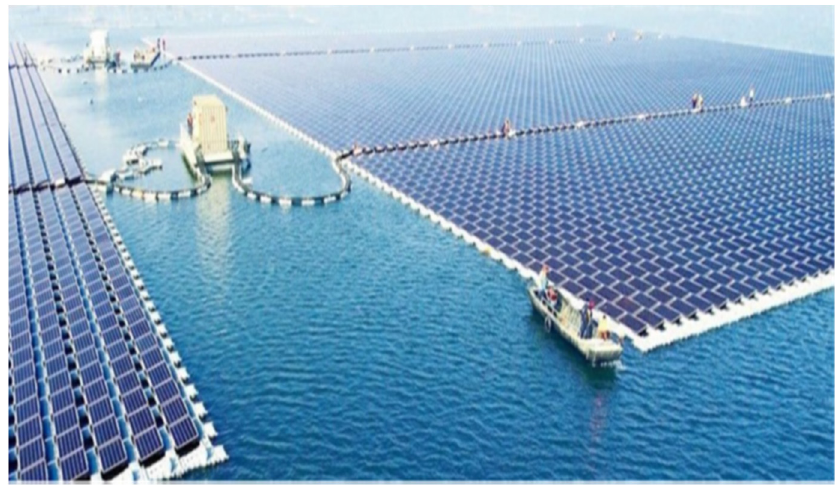
Figure 1. Floating solar power plant (Source: Brandon, 2017 [23]).